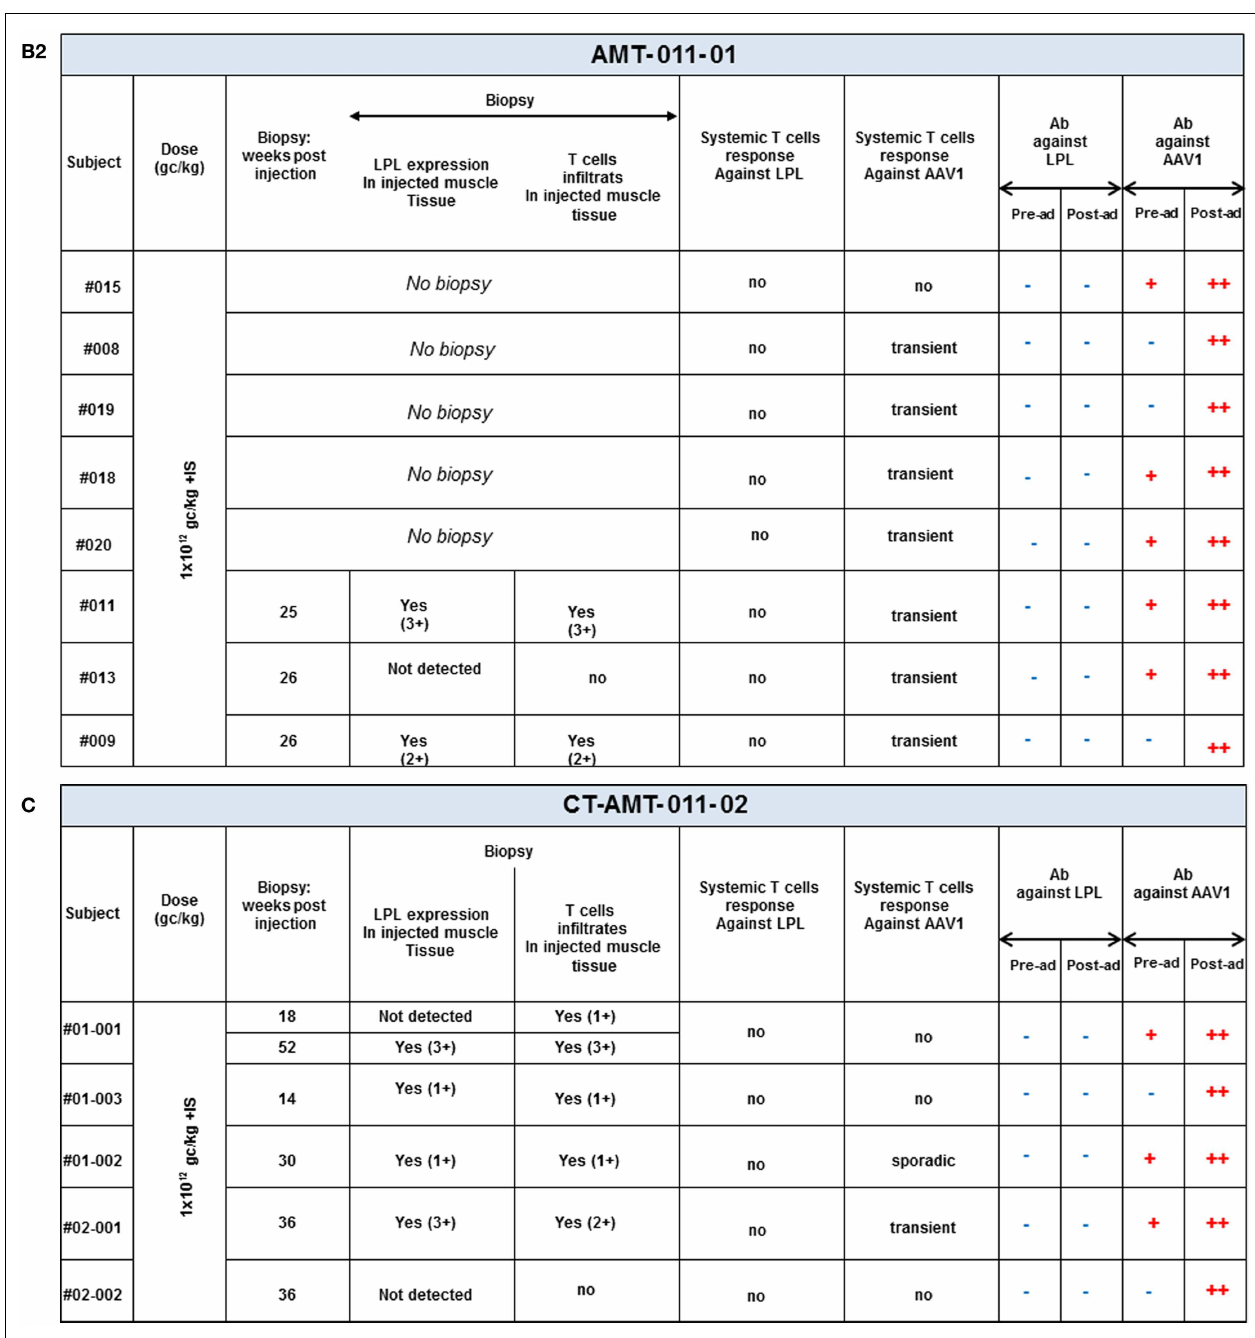
> 50 SFU per million cells, and when that number was at least threefold higher than that of the medium control. AT-cell response to the antigen was reported transient positive (transient) when at least two consecutive sampling time points were measured positive in the ELISpot assay.The patient reported “sporadic” present recurrent non-consecutiveT-cell response over time.When none or only one sampling time was measured positive, theT-cell response was reported negative ( − ). Antibodies: the test results of the samples were scored by comparison with those of a negative control (a serum sample from a healthy human control).To this end, algorithms were developed to convey the optical density results into a semi-quantitative scoring system. Based on the algorithms, samples were said to be strongly positive ( ++ ), weakly positive ( + ), or negative for AAV1 antibodies and positive ( + ) or negative ( − ) for anti-LPL